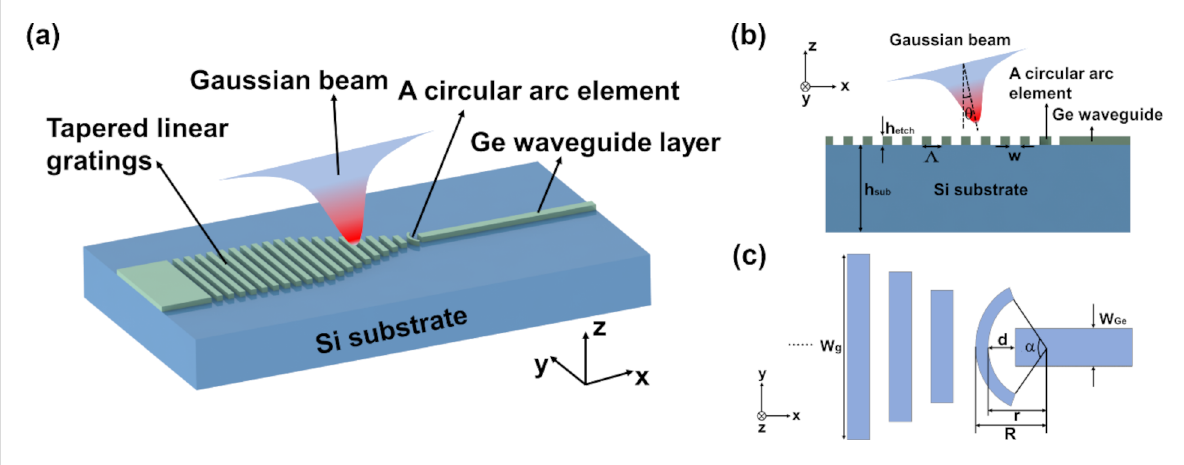
Figure 1: (a) Tilted view and (b) cross-sectional view of the proposed MIR grating coupler. (c) Schematic diagram of the proposed CAE in the MIR grating